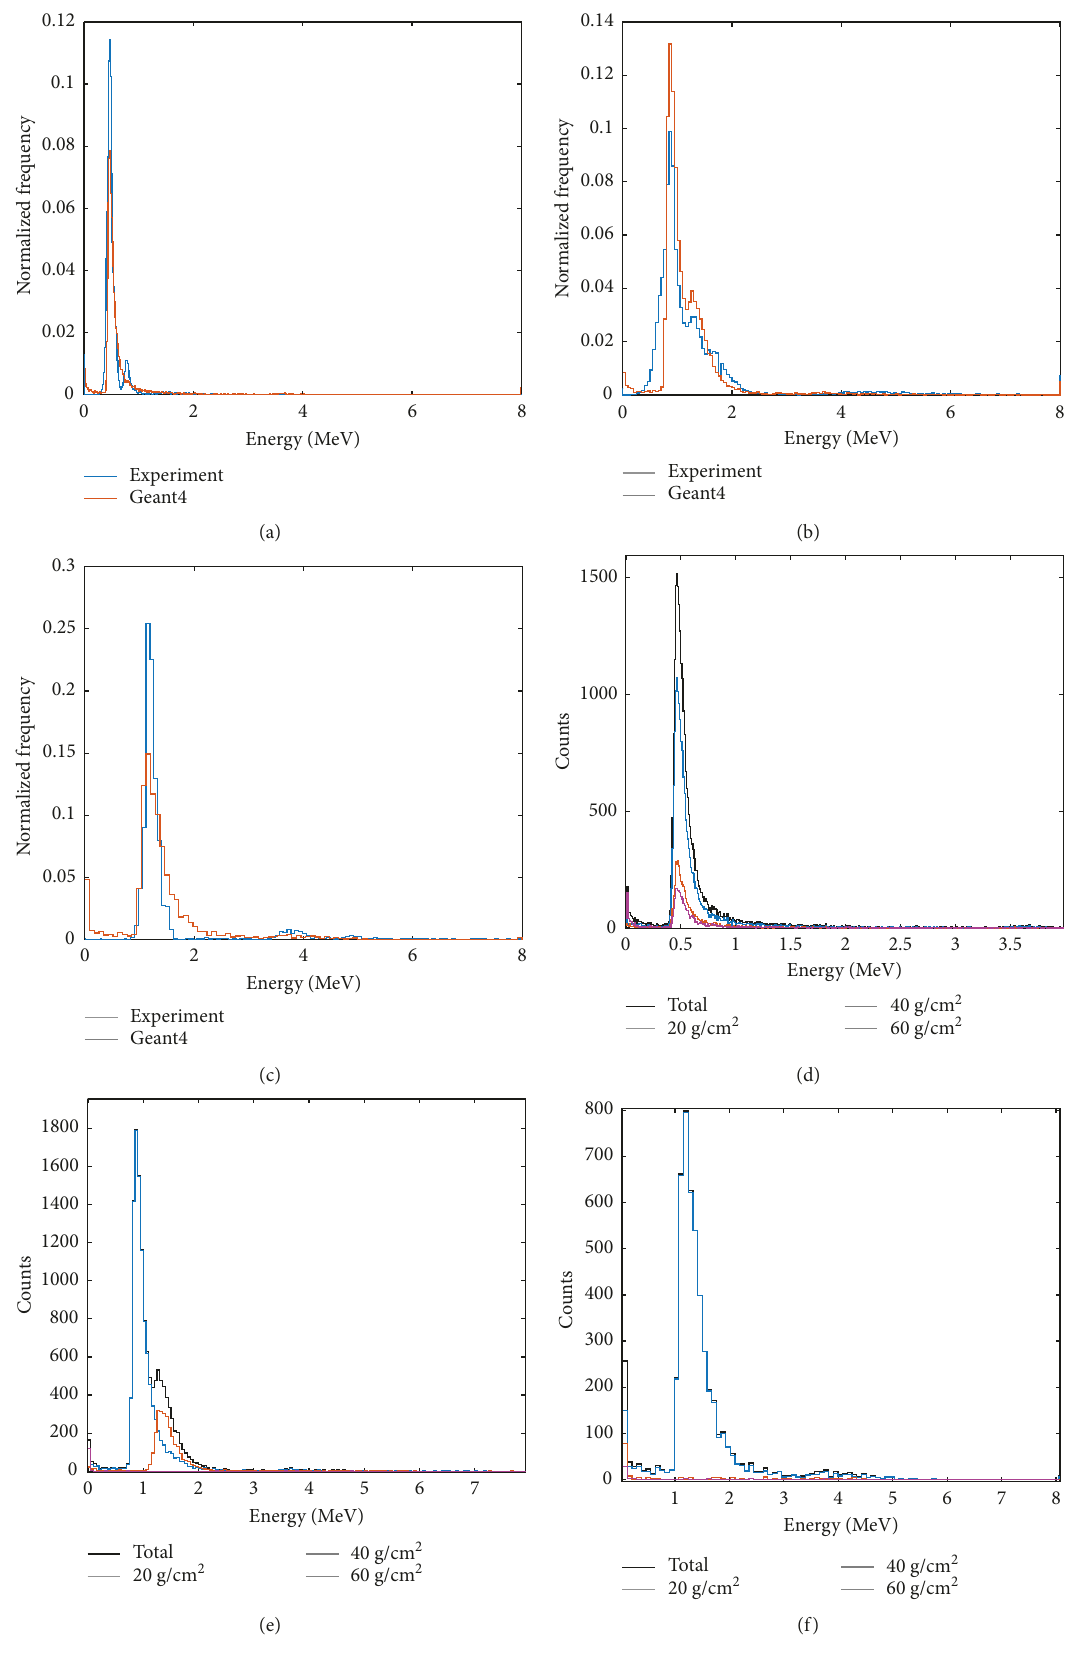
Figure 5: Experimental versus simulation spectra for (a) 2.5GeV, (b) 800MeV, and (c) 400MeV proton beams, respectively. Simulated spectra for different upstream target thicknesses: (d) 2.5GeV, (e) 800MeV, and (f)